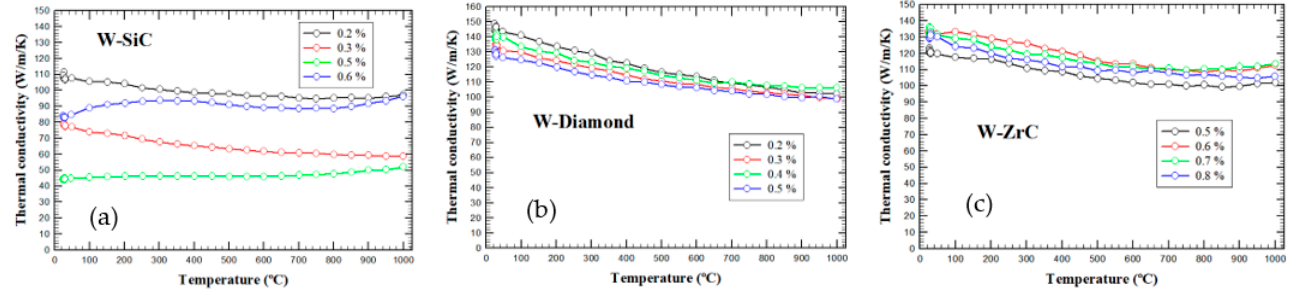
Figure 8. Temperature-dependent thermal conductivity of W-ceramic composites for different dis- persion concentrations: ( a ) W-SiC materials, ( b ) W-diamond materials and ( c ) W-ZrC materials.